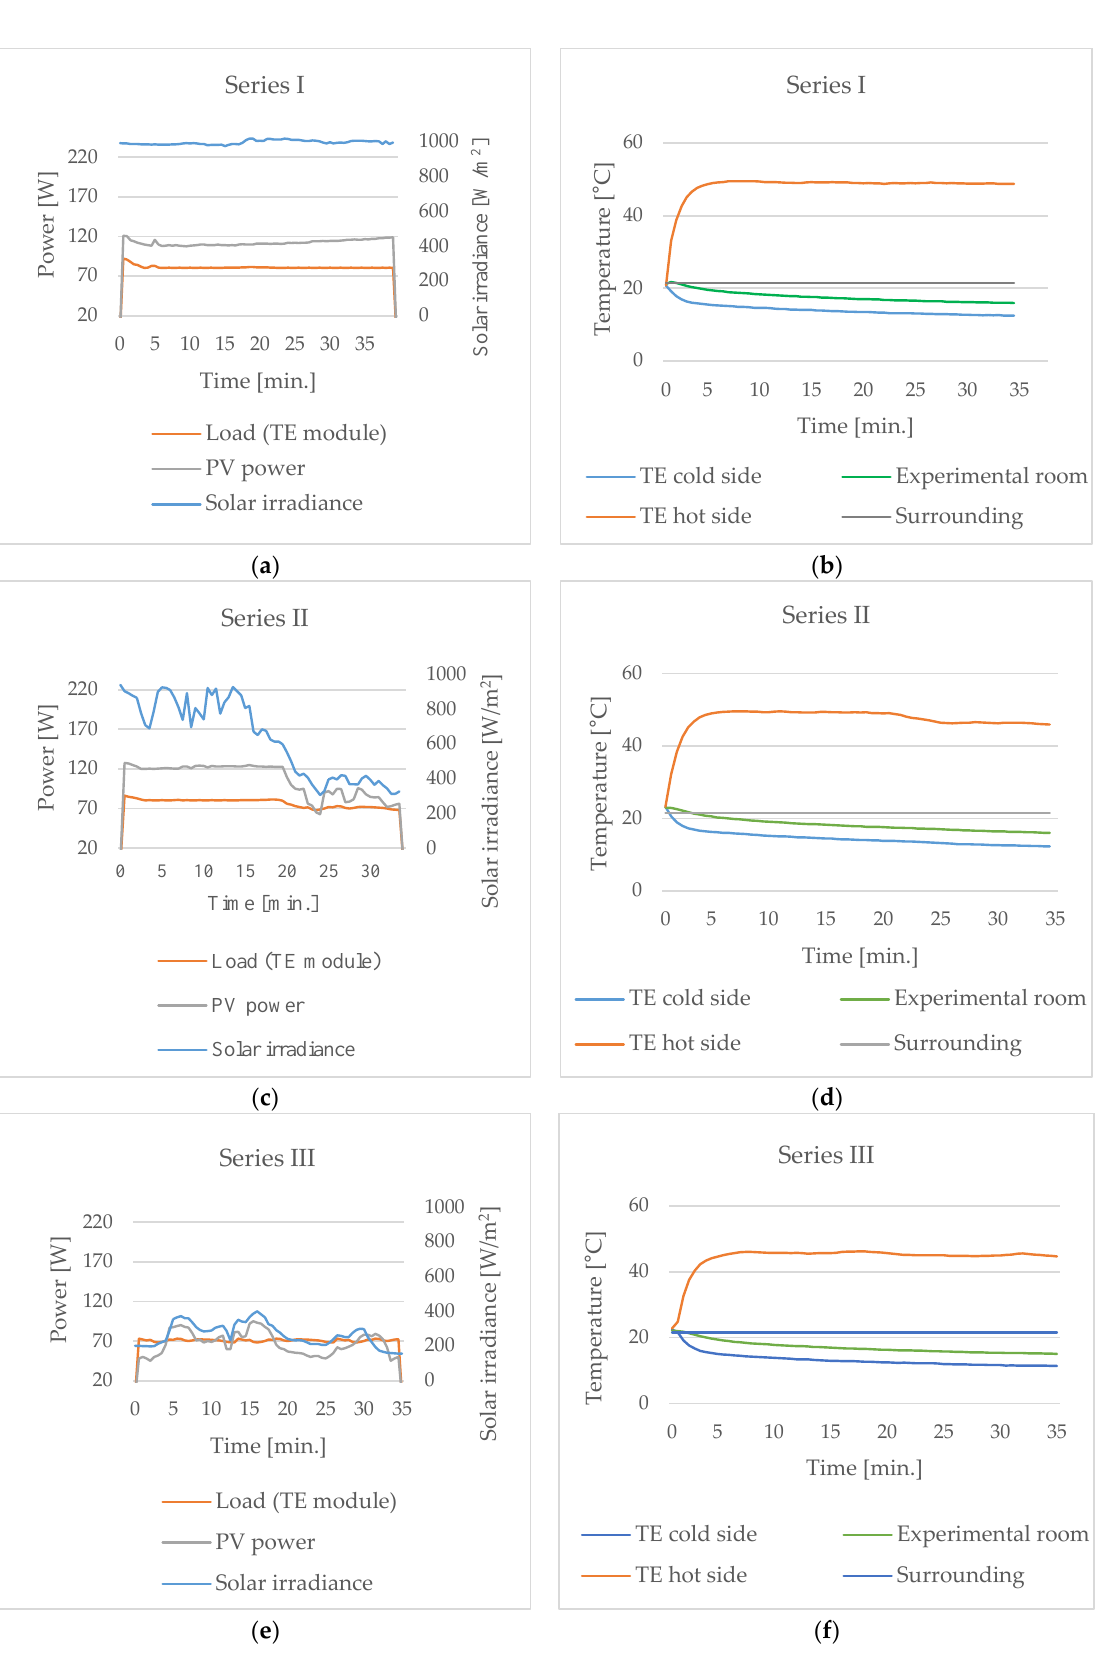
Figure 4. Operation parameters during Stage 1: ( a ) power in Series I; ( b ) temperatures in Series I; ( c ) power in Series II; ( d ) temperatures in Series II; ( e ) power in Series III; ( f ) temperatures in Series III.